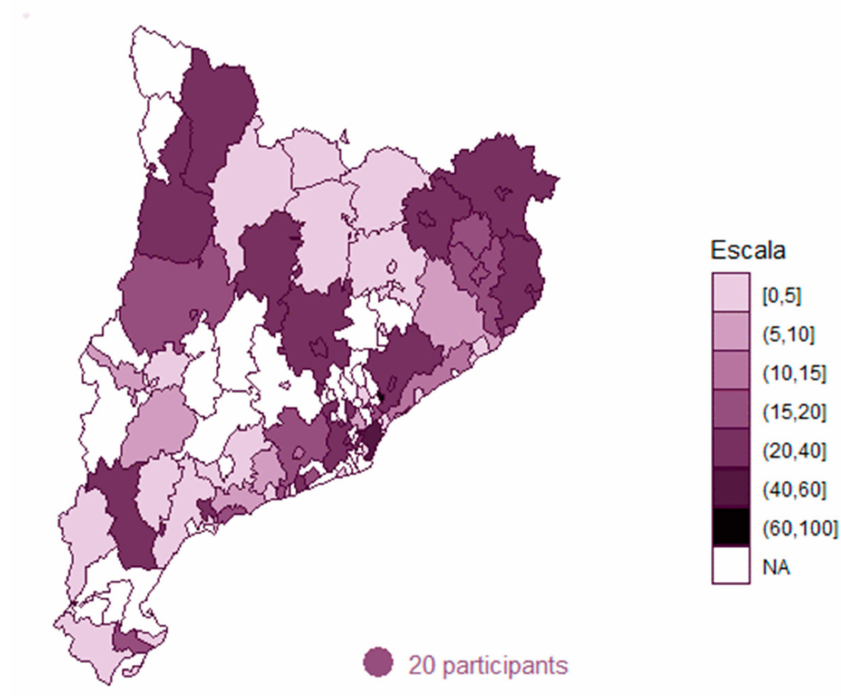
Figure 17. Number of responses per